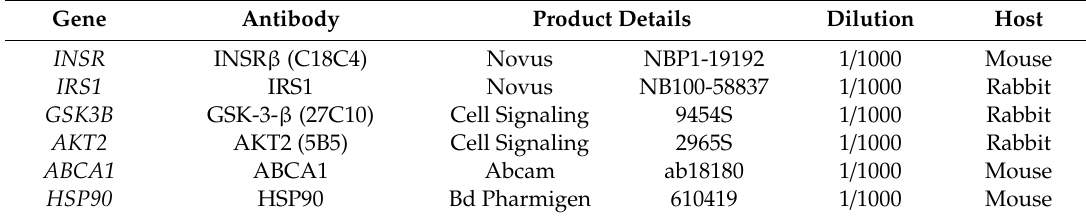
Table A2. List of antibodies used for Western blot analysis.